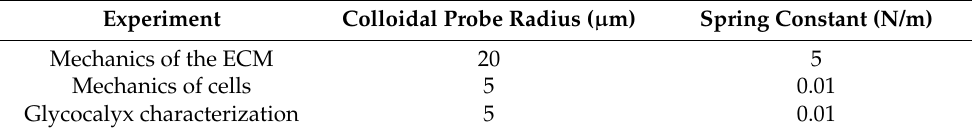
Table 2. Radius and typical spring constant of the AFM probes used for every experiment. Experiment Colloidal Probe Radius ( µ m) Spring Constant (N/m) Mechanics of the ECM 20 5 Mechanics of cells 5 0.01 Glycocalyx characterization 5